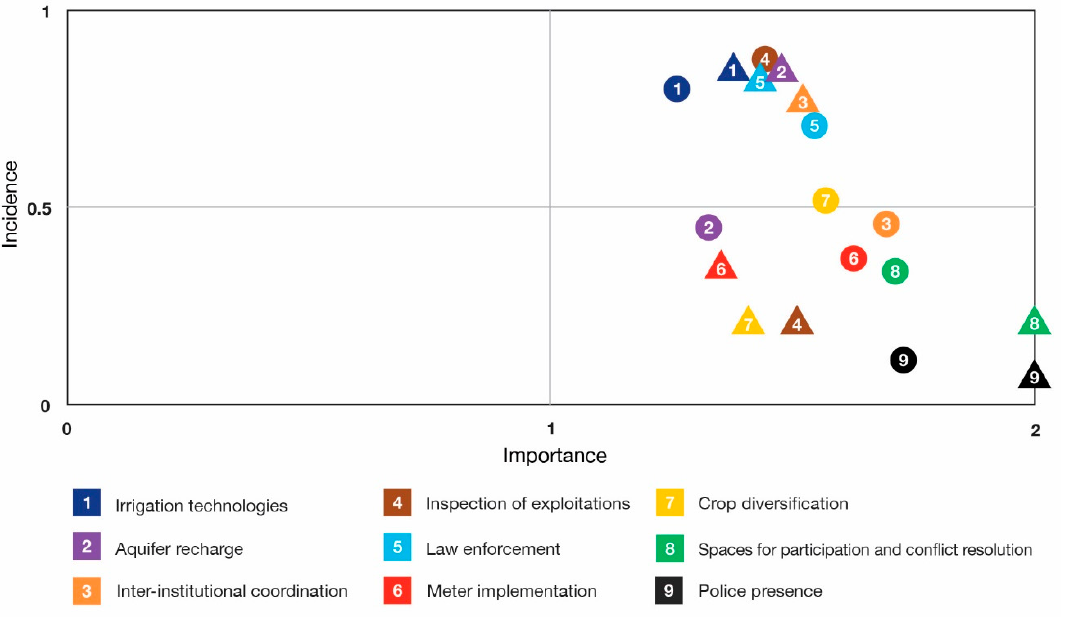
Figure 8. A scatter graph that displays the needs identified by Mexican farmers (circles) and Mennonites (triangles) according to their importance and incidence. The importance index ranges from 0 (least important) to 2 (most important), and the incidence index ranges from 0 (not mentioned) to 1 (most mentioned).